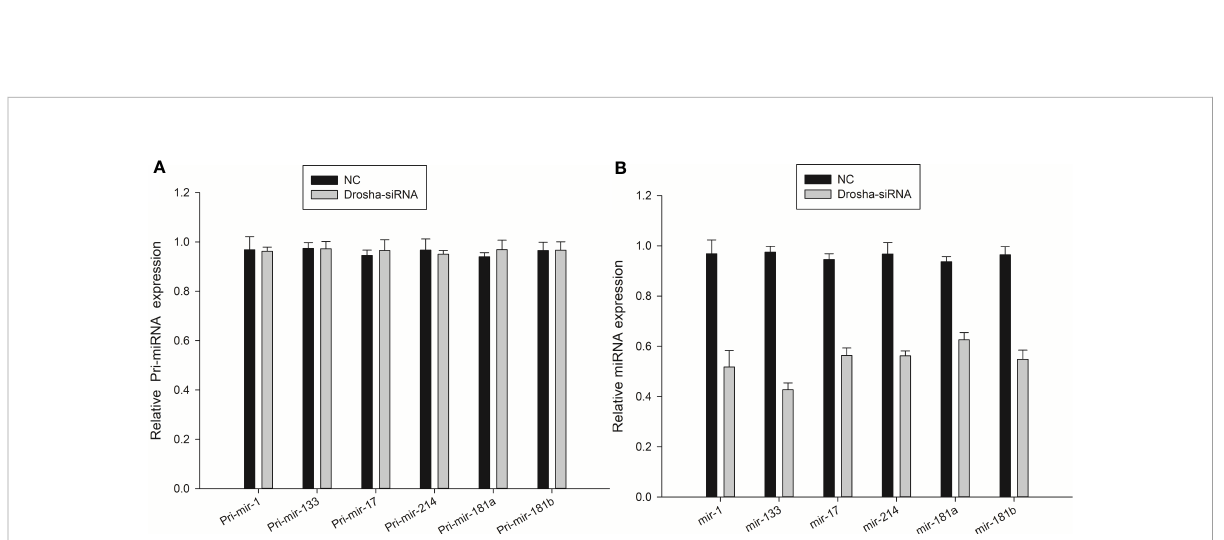
FIGURE 8 Expression of pri-miRNA (A) and mature miRNA (B) in transfected Drosha -siRNA. NC: Drosha -siRNA-FAM-NC, The siRNA sequence is not present in the fi sh.